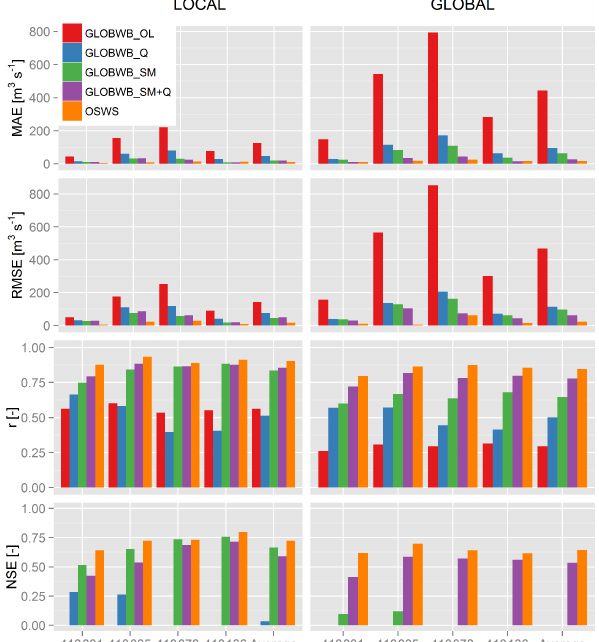
Figure 9. Evaluation results for streamflow estimates at station nos. 410001, 410005, 410078 and 410136 in the Murrumbidgee River. Average values calculated across those locations are shown in the rightmost bar of each histogram. In the rows, four different eval- uation metrics are shown; from top to bottom, these are the MAE, RMSE, r and the NSE. Columns show various forcing data: local and global.